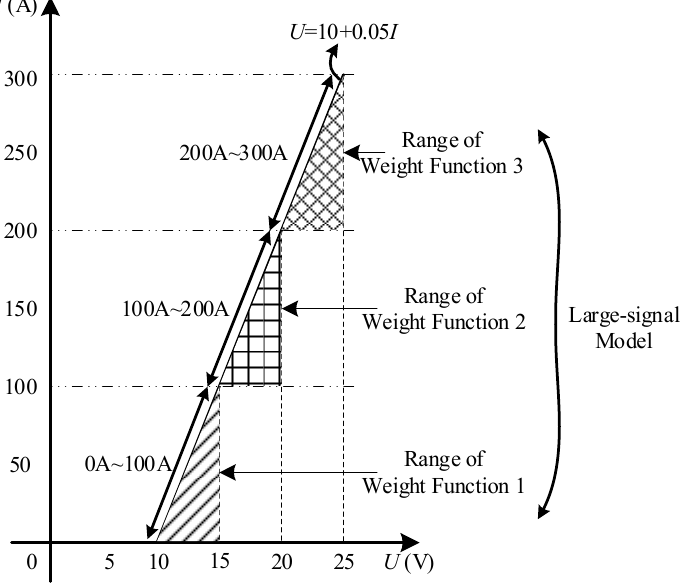
Figure 11. Region divided by large signal model.